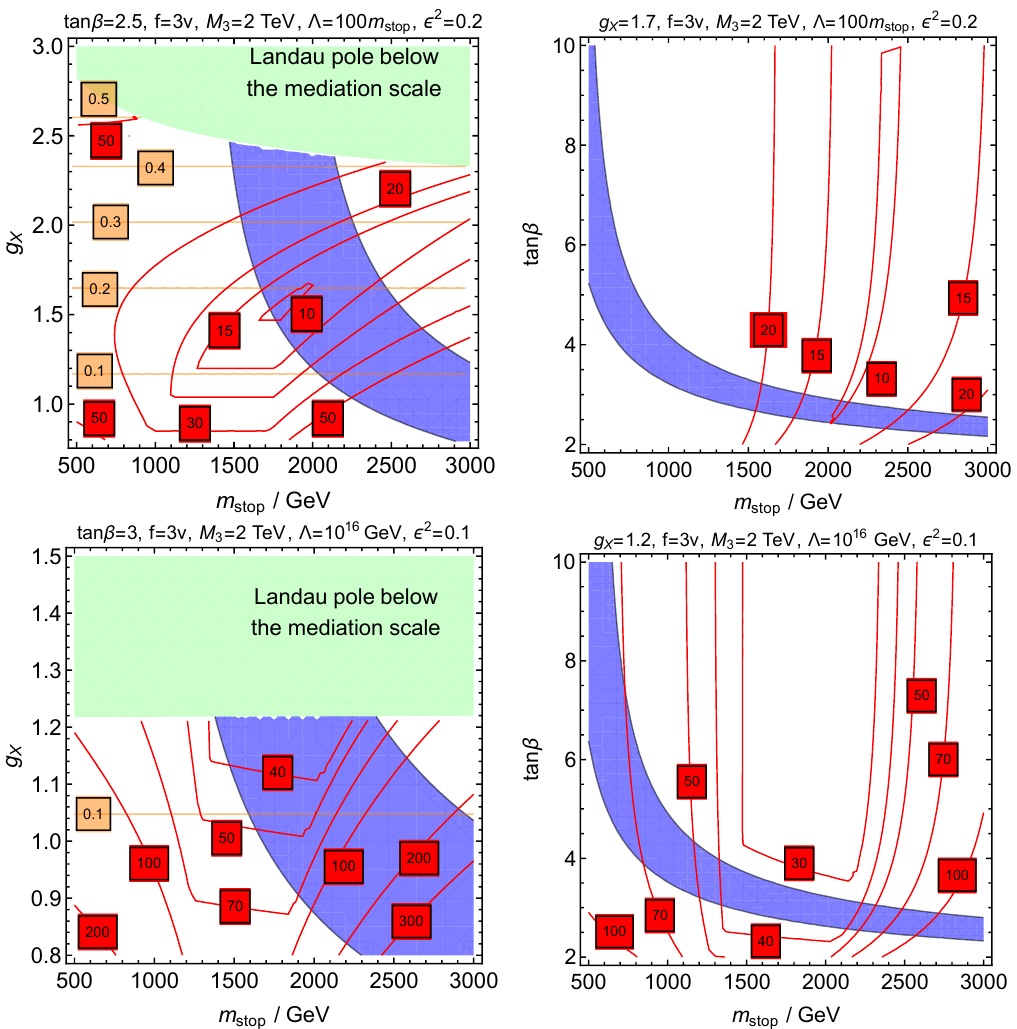
Figure 2 . Fine-tuning (red contours) in the model for f = 3 v , (cid:22) = M 1 = M 2 = 500 GeV, m A = 1 TeV and the soft gluino mass term M 3 = 2 TeV assuming the mediation scale (cid:3) = 100 m stop (upper panels) and (cid:3) = 10 16 GeV (lower panels). In the left panels, the orange contours depict the value of the SU(4) preserving quartic coupling and in the green regions the Landau pole of the SU(2) X gauge coupling constant is below (cid:3). In the upper (lower) left panels, tan (cid:12) = 2 : 5 (3) so that the correct Higgs mass m h = 125 (cid:6) 3 GeV (the blue region) is obtained for stop masses close to 2 TeV for the most interesting range of g X . In the right panels, the (cid:12)ne-tuning is shown in the plane m stop -tan (cid:12) for some (cid:12)xed values of g X . m X is chosen such that the constraint from EW precision measurements is saturated | see appendix for